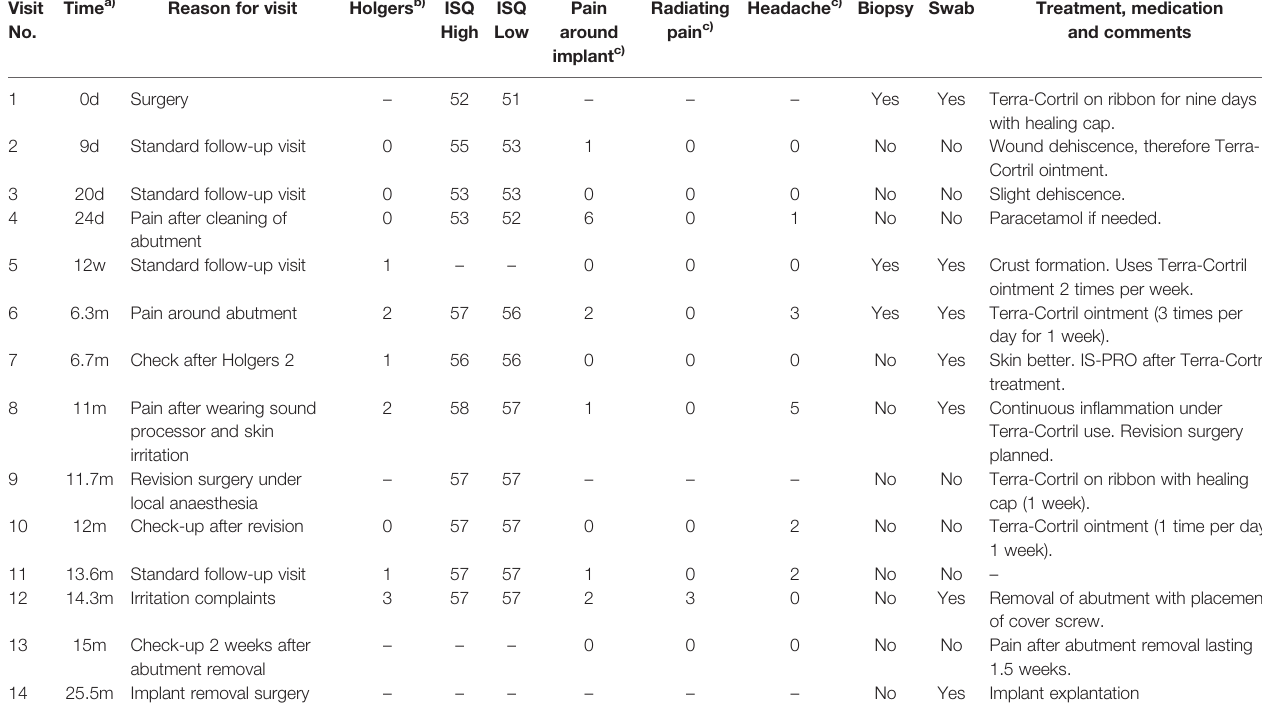
TABLE 1 | Clinical outcomes, samplings, and treatments at the visits. Visit